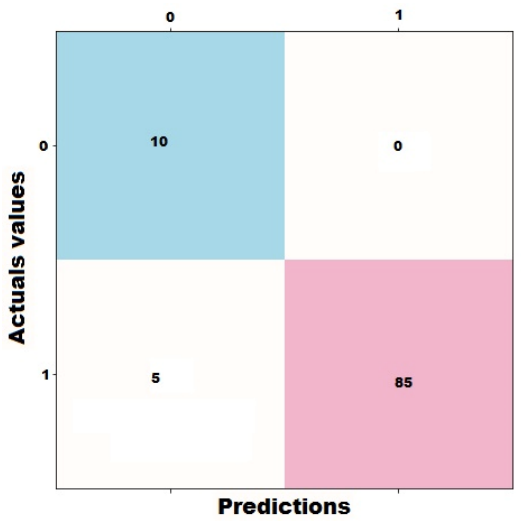
Figure 12. Predictions versus actual values on test data using the confusion matrix .